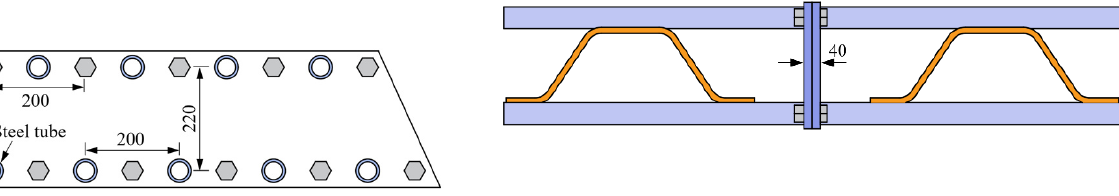
Figure 6. Structural parameters of the end-plate joint.